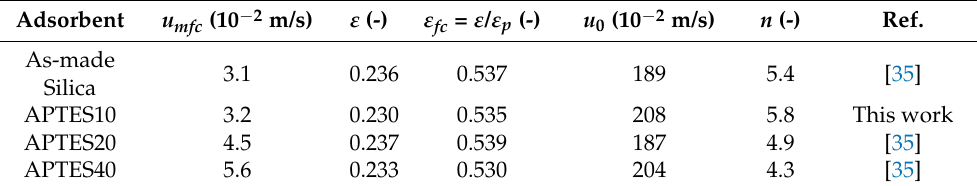
Table 4. Confined fluidization properties of the adsorbent particles.